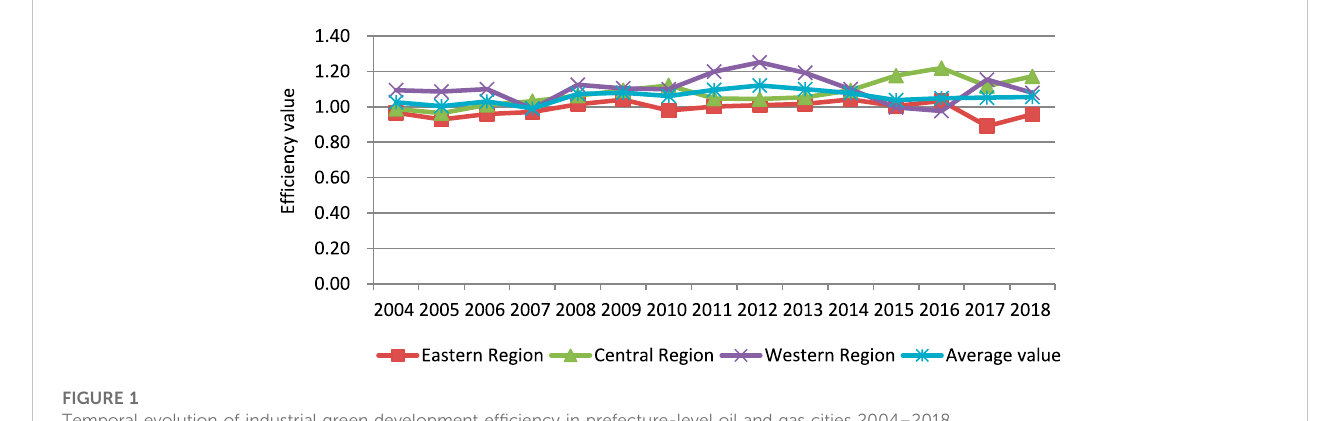
FIGURE 2 Trends in industrial value added in oil and gas cities, 2004 – 2018 (unit: RMB one hundred million).